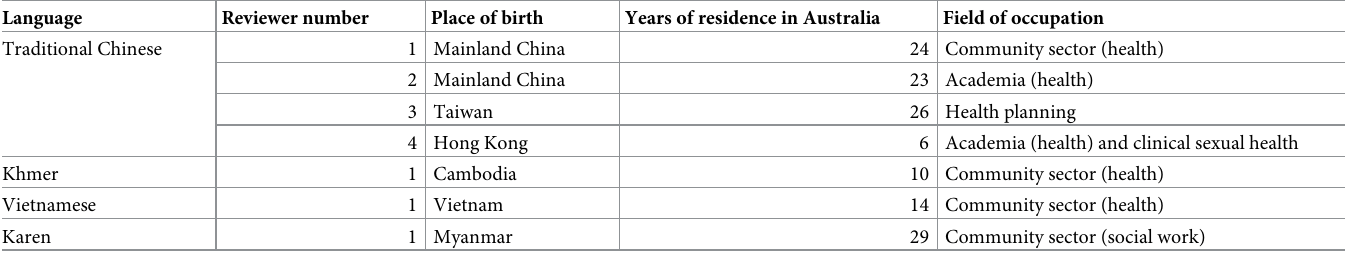
Table 2. Summary of reviewer characteristics, by